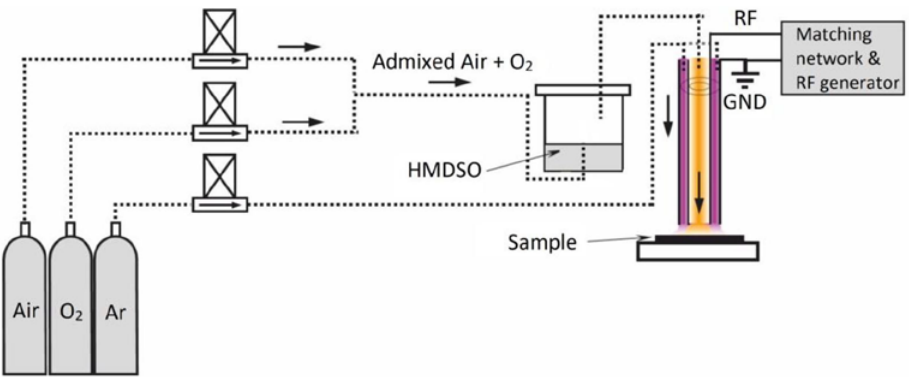
Figure 2. The schematic of the atmospheric pressure RF plasma deposition system.